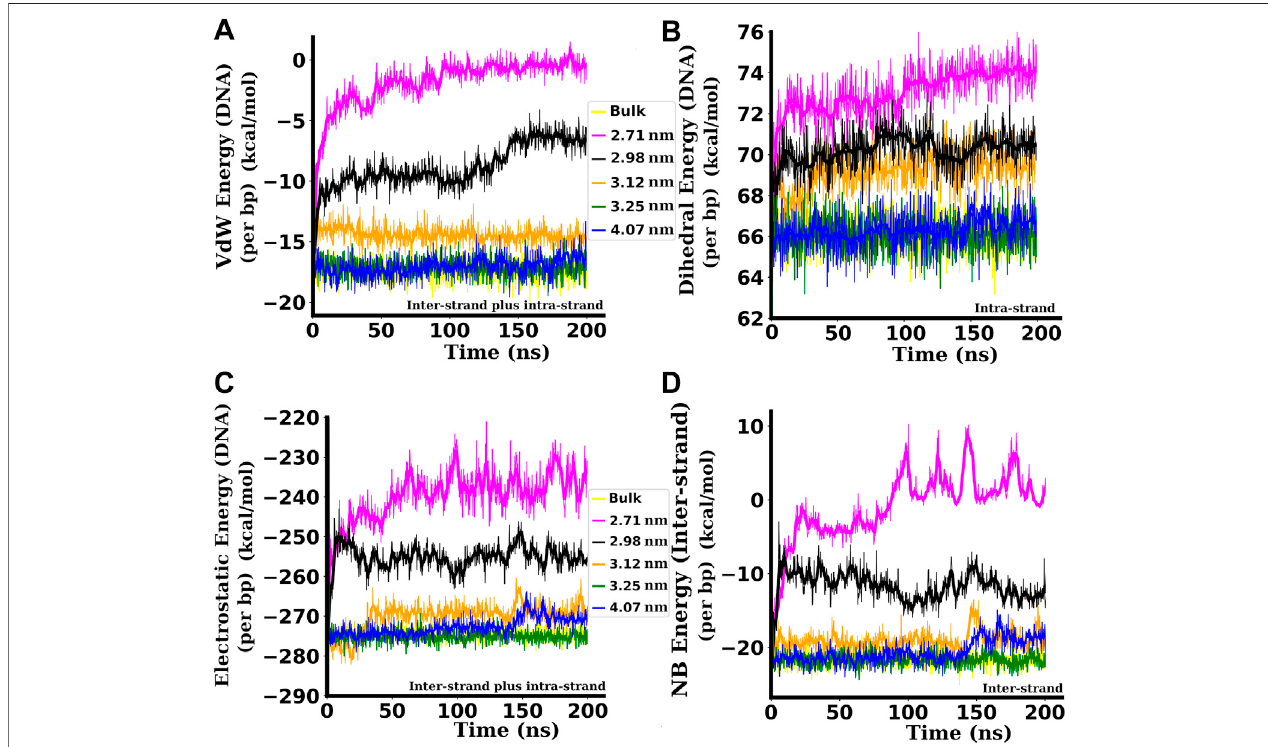
FIGURE 7 | Different bonded and non-bonded interaction energies per bp between the bases of the dsDNA. (A) Inter and intra-strand Van der Waals (VdW) energiesofthedsDNA. (B) intra-strand dihedral energiesofthedsDNA. (C) Interand intra-strandelectrostaticenergiesofthe dsDNA. (D) Inter-strand (without including intra-strand) non-bonded (NB) energies (VdW + Electrostatic) between two strands of the dsDNA. Attractive ( − ve) interaction energies are decreased in magnitude, and repulsive(+ve)interactionenergiesareincreasedwhenthedsDNAiscon fi nedinsidenarrowerSWCNTs.Alltheinteractionenergiespresentedhereareinkcal/mol. Here, the inter-strand term is used for interaction energies between the residues of two different strands of dsDNA, and the intra-strand is used for the interaction energies between the residues of the same strand.